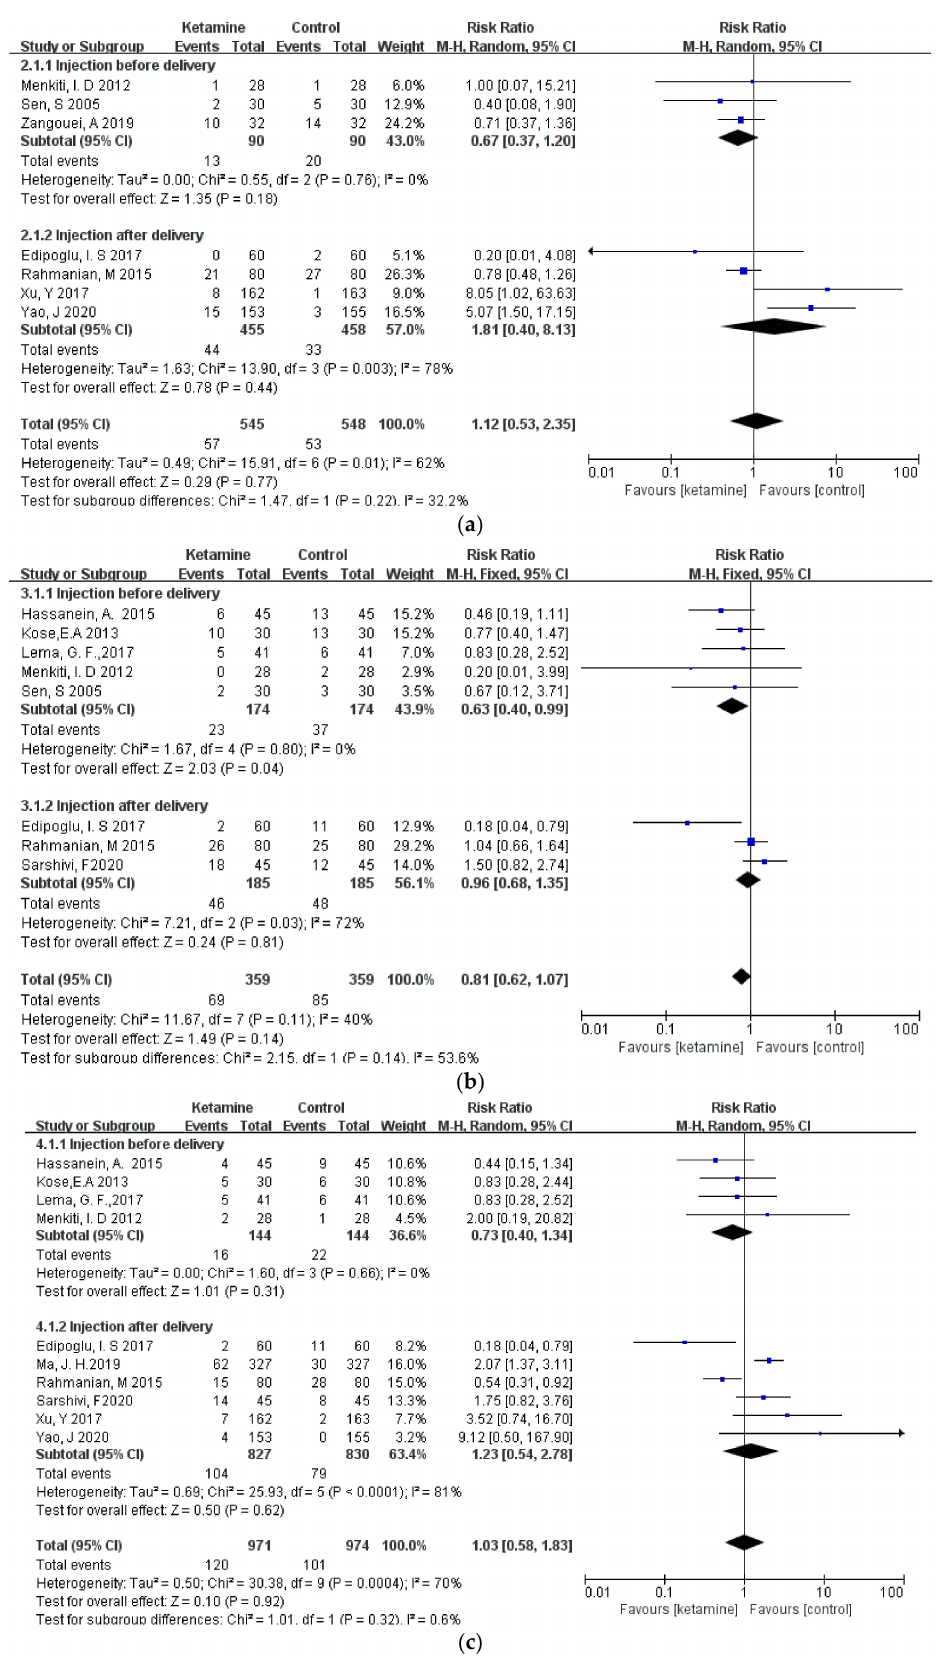
Figure 6. Forest plot of subgroups [12–23]: ( a ) headaches; ( b ) nausea; ( c )